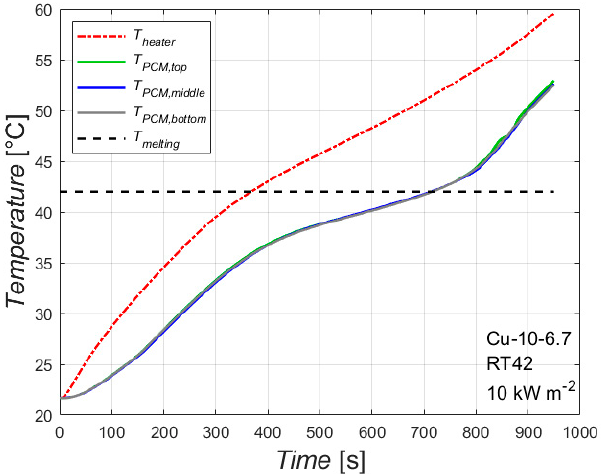
Figure 3. Temperature profiles during melting of the paraffin RT42 inside the 10 PPI copper foam with a porosity of 0.933 with an imposed heat flux of 10 kW m − 2 . The red line represents the average temperature of the plate in contact with the